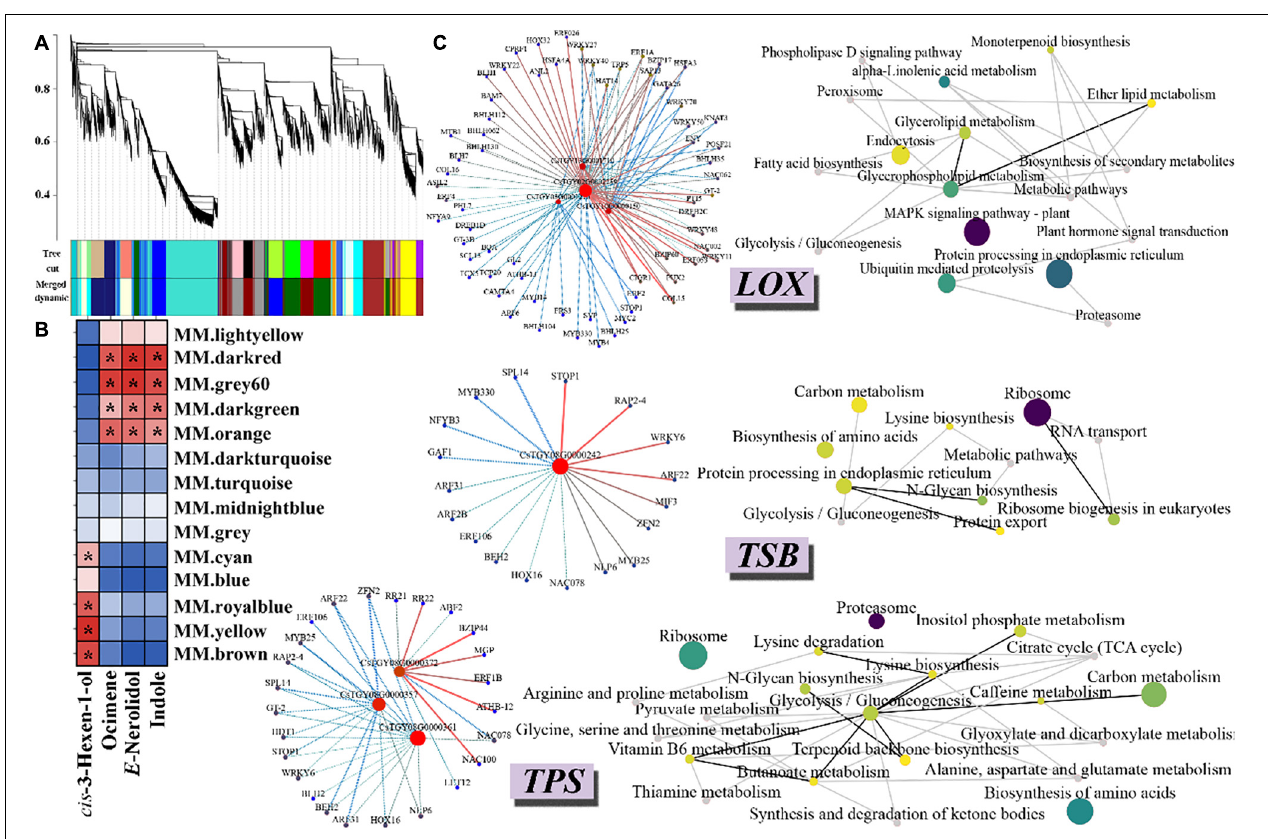
FIGURE 5 | Co-expression network of wounding-induced volatile formation. (A) Hierarchical clustering tree of DEGs based on WGCNA analysis. Each short black line (“leaf”) represents an individual gene. Different colored boxes below the hierarchical clustering tree represent genes with similar expression patterns, and these genes were clustered based on dissimilarity measures. Cut tree represents the cut height of the cluster tree; Merged dynamic represents further merge similar modules according to module eigengene. (B) Correlation heat map of four volatile substances and each module. Red and blue indicate high and low correlations, respectively. “*” indicates a significant correlation between the module and volatile substances ( p < 0.05). The correlation value has been scaled. (C) Co-expression network diagram of candidate genes. The left side shows the TF-gene regulation network. When the weight value is greater than 0.5, we believe that there is a regulatory relationship between the candidate genes and TFs. The red dots represent the LOX, TSB, and TPS, respectively. The left side shows the KEGG undirected network diagram. The structural genes that have a potential relationship with candidate genes (weight value < 0.15) were chosen to construct a KEGG undirected network. The node size and color represents the number of genes enriched into the pathway. The larger purple node represents more genes in this pathway, and smaller yellow circles represent fewer